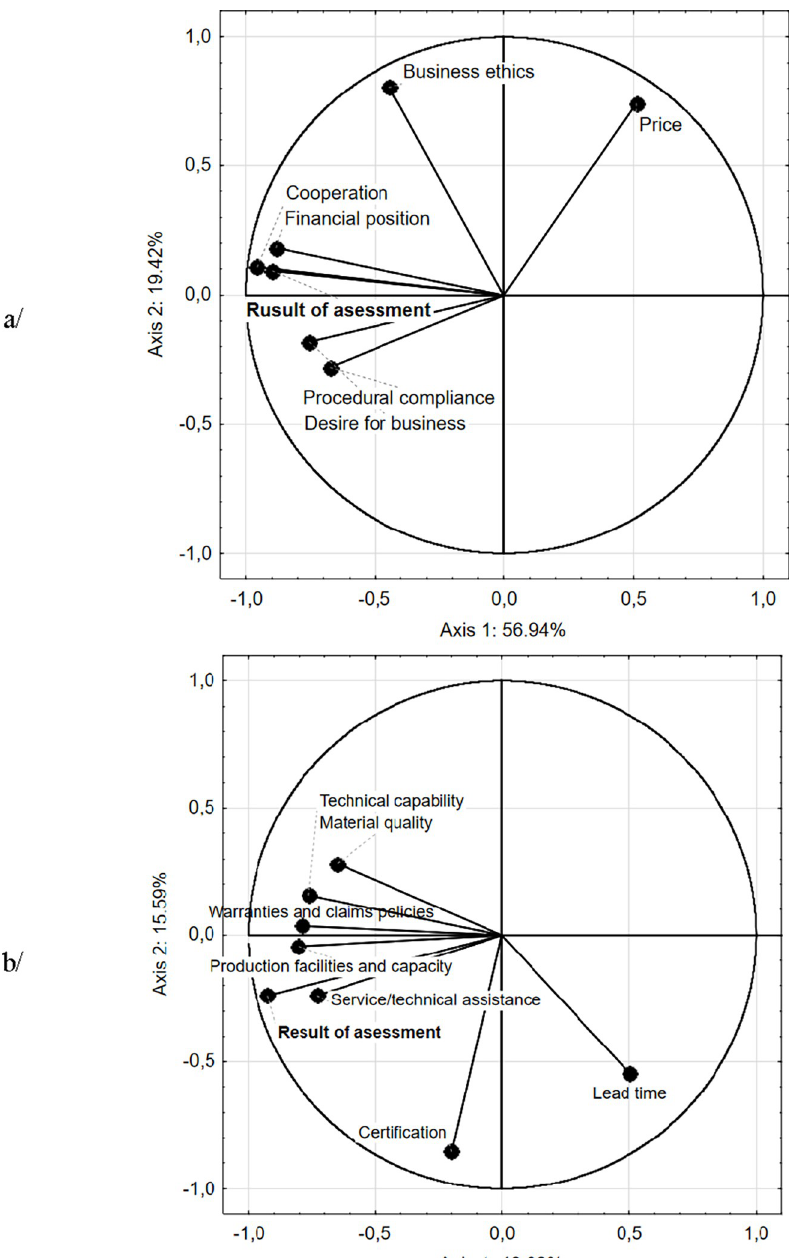
Fig 1. Influence of (a) economic, and (b) quality and processing criteria on the result of suppliers evaluation. All the supplier characteristics i.e. supplied materials (3.1), the location of the supplier (3.2) and the departments when supplied materials were used (3.3) significantly influenced the total results of the supplier evaluation (p value ANOVA: supplied materials, p = 0.000; location, p = 0.000; department, p = 0.0000). The Fisher’s least significant difference test (LSD) was then used to determine the differences between supplier subcategories. In the case of the supplied materials category (no. 3.1) (Fig 2A), the suppliers of raw materials directly involved in